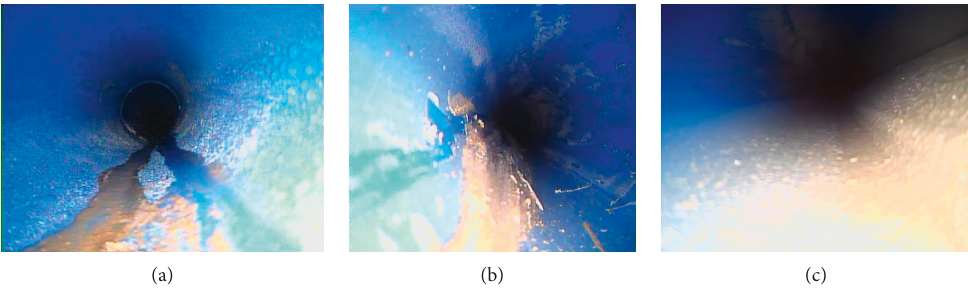
Figure 11: Silicone rubber coated pipe. (a) October 28, 2016. (b) January 28, 2017. (c) April 28, 2017.